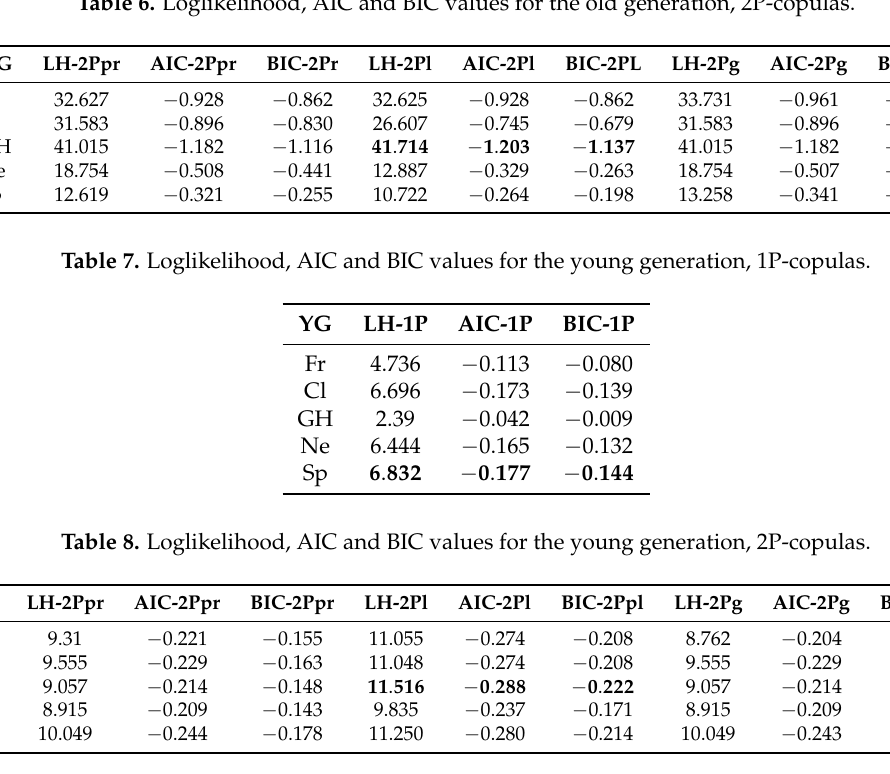
Table 6. Loglikelihood, AIC and BIC values for the old generation, 2P-copulas.